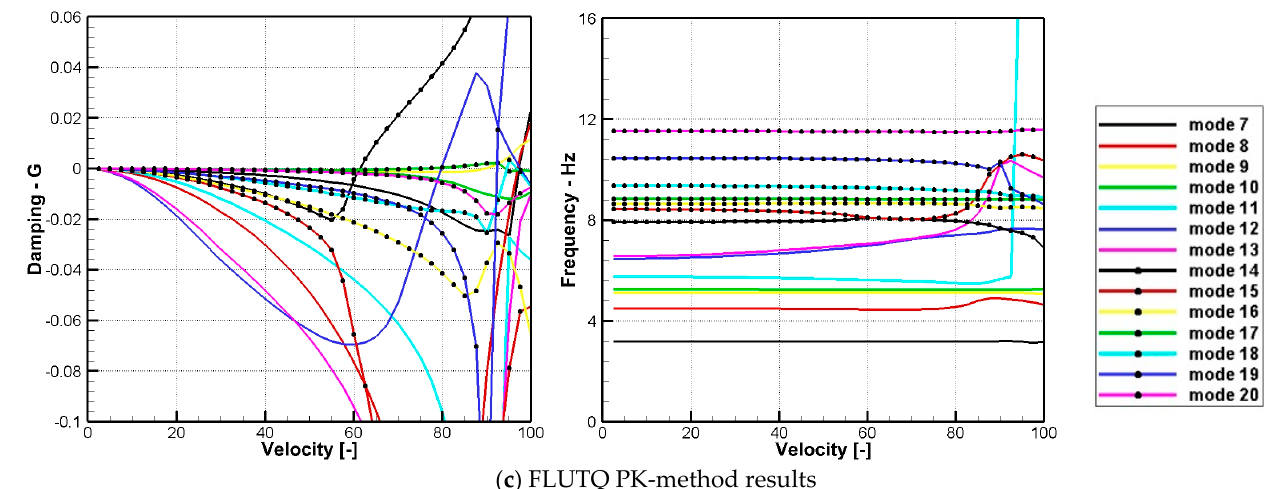
Figure 8. Ineffectiveness of mode tracking: damping and frequency diagrams for the Asymmetric 2 configuration of the real-world jet aircraft with velocities arbitrarily normalized.